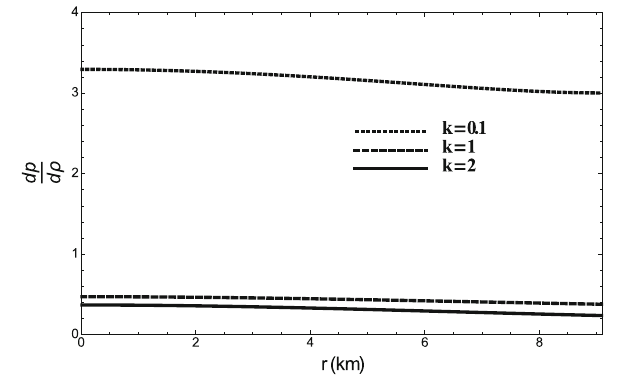
Fig. 7 Dependance of sound speed on k